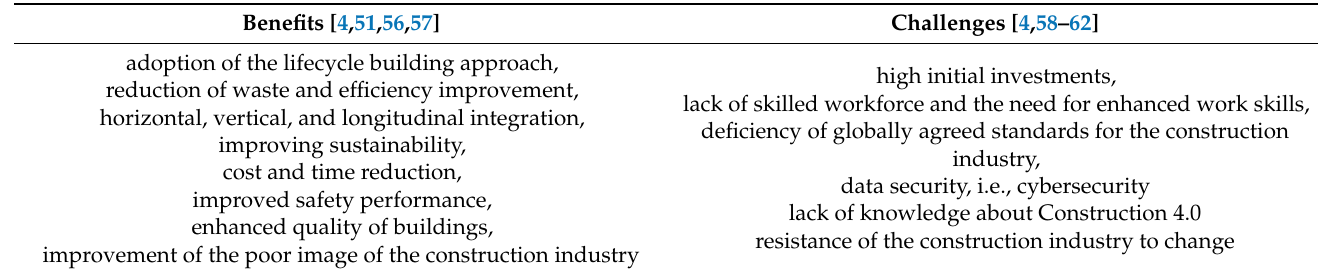
Table 1. Construction 4.0: main benefits vs. main challenges.